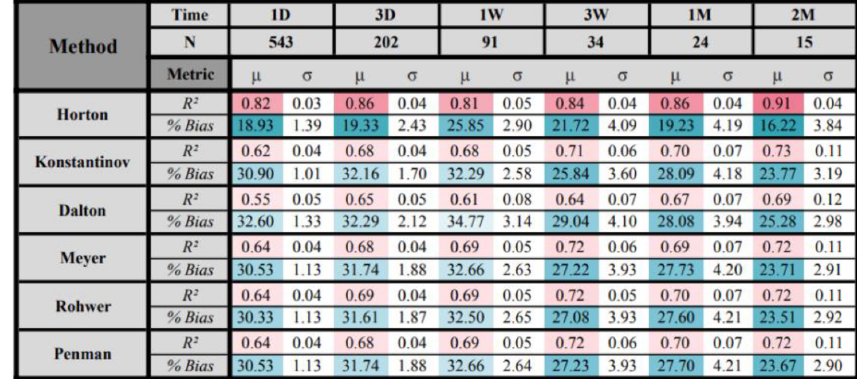
Table 2. Performance metrics ( R 2 and percent bias) for evaporation methods using reanalysis-based disaggregated actual vapor